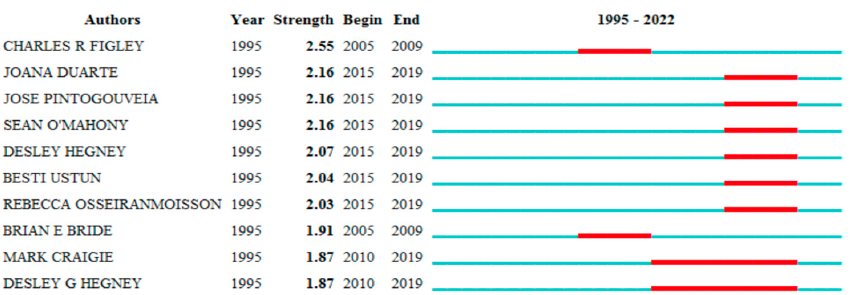
Figure 5. Overlay network and clusters of authorship.